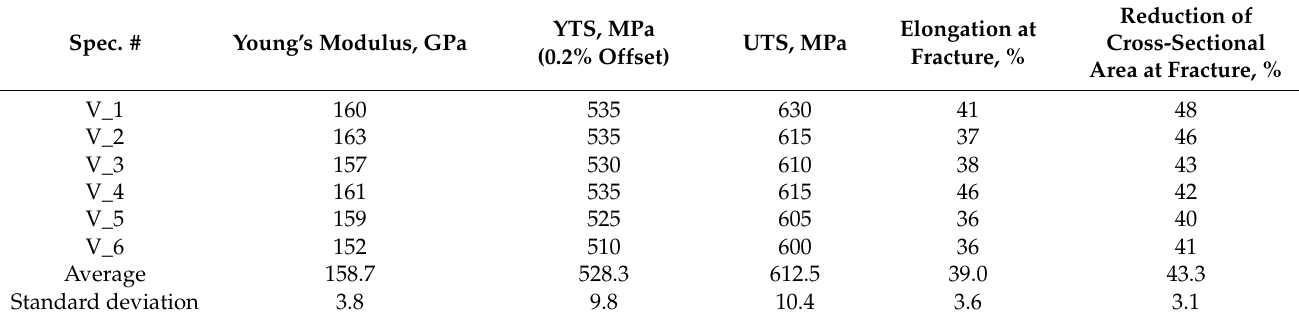
Figure 4. Tensile test results of LPBF processed as-build 316L samples. Table 2. The measured mechanical properties of “V” set.